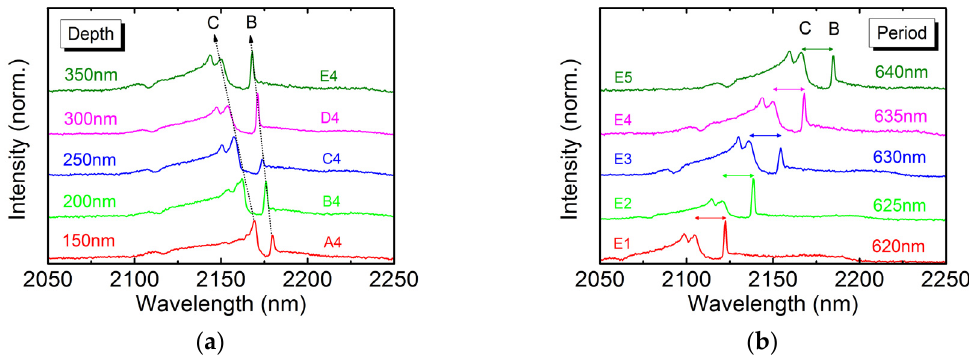
Figure 6. The below-threshold emission spectra for devices with ( a ) 635-nm-period but varying etching depth (A4 to E4) and ( b ) 350-nm-deep but varying period (E1 to E5).